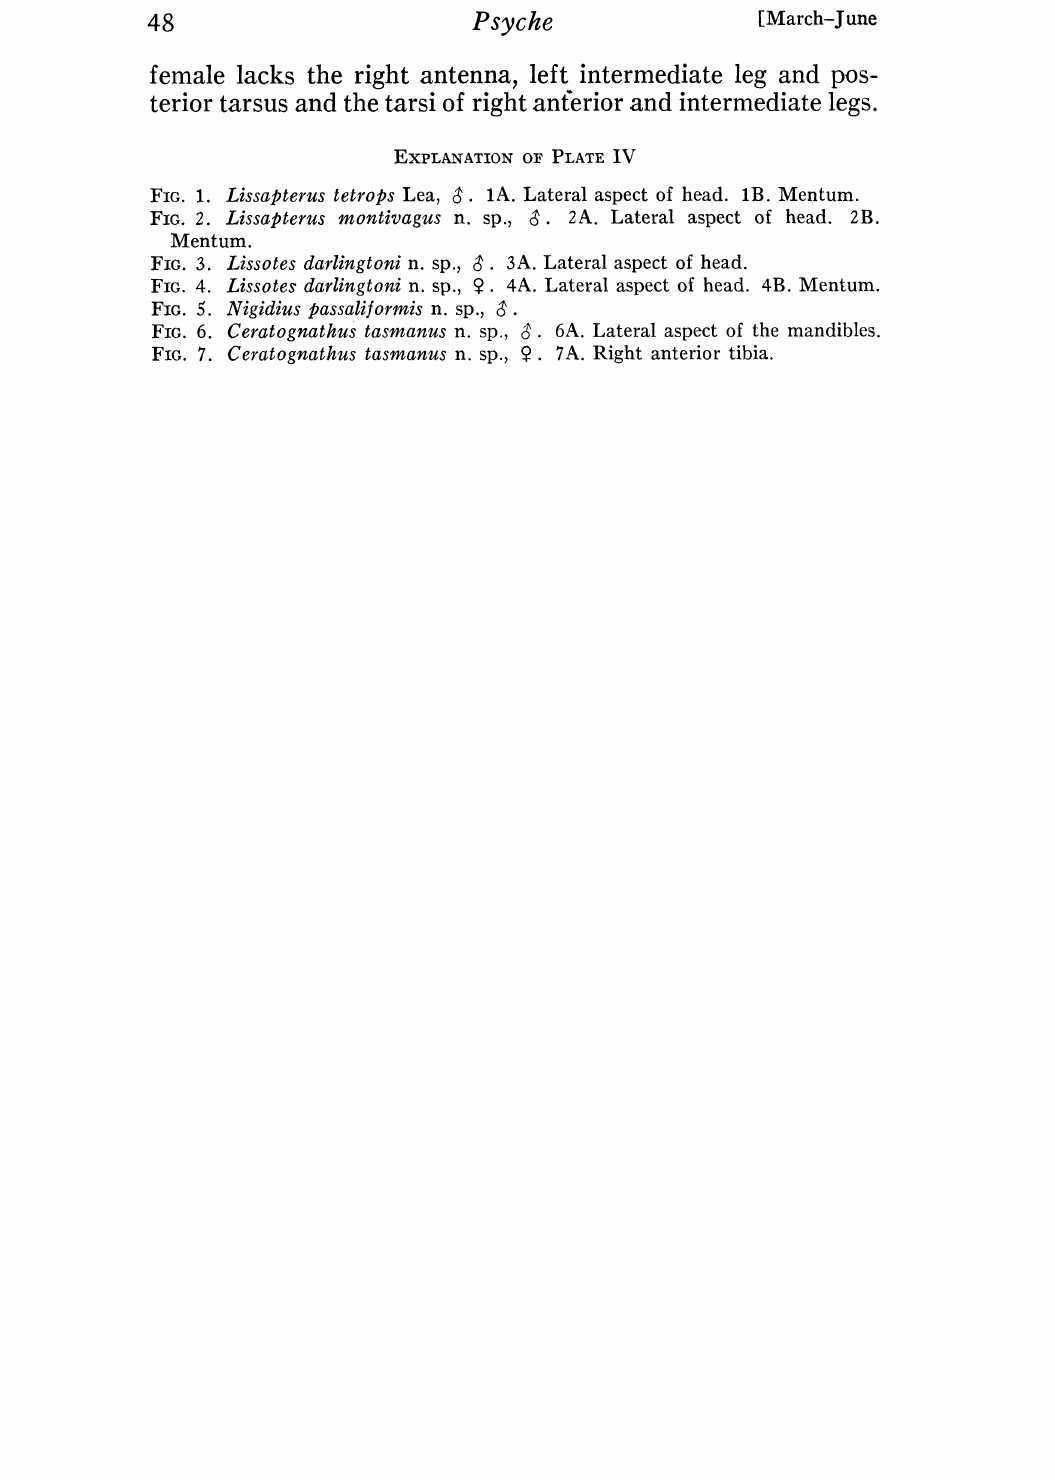
FIG. 1. Lissapterus tetrops Lea,